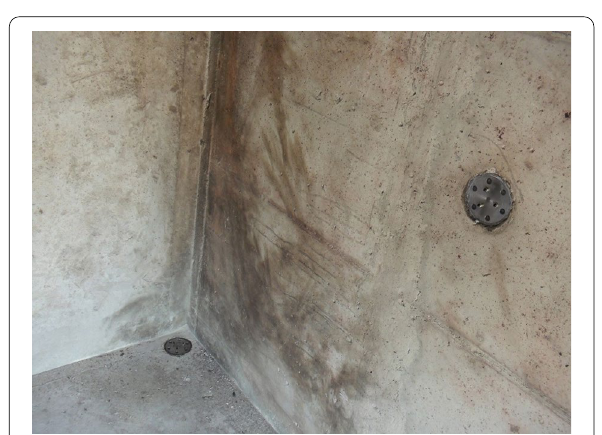
Fig. 4 Reflective pressure sensor installation shape.